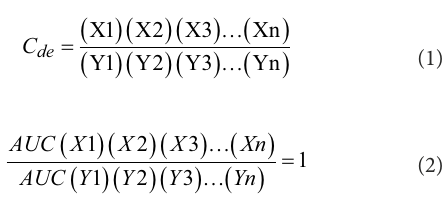
baseline, where the red and blue lines overlap on the horizontal